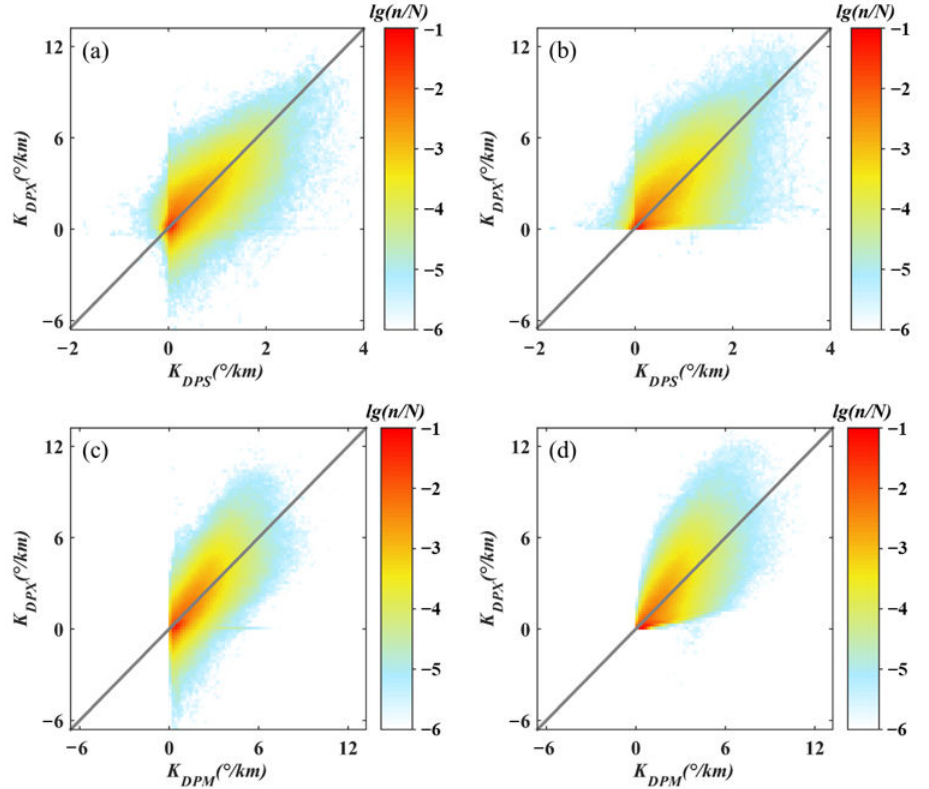
Figure 9. Based on the δ -elimination processing of Φ DP , this figure shows the distribution of ( a ) K DPS from S-POL vs. K DPX calculated by LS, ( b ) K DPS from S-POL vs. K DPX calculated by LP, ( c ) K DPM calculated using fitting relation of polarimetric variables vs. K DPX calculated by LS, ( d ) K DPM calculated using fitting relation of polarimetric variables vs. K DPX calculated by